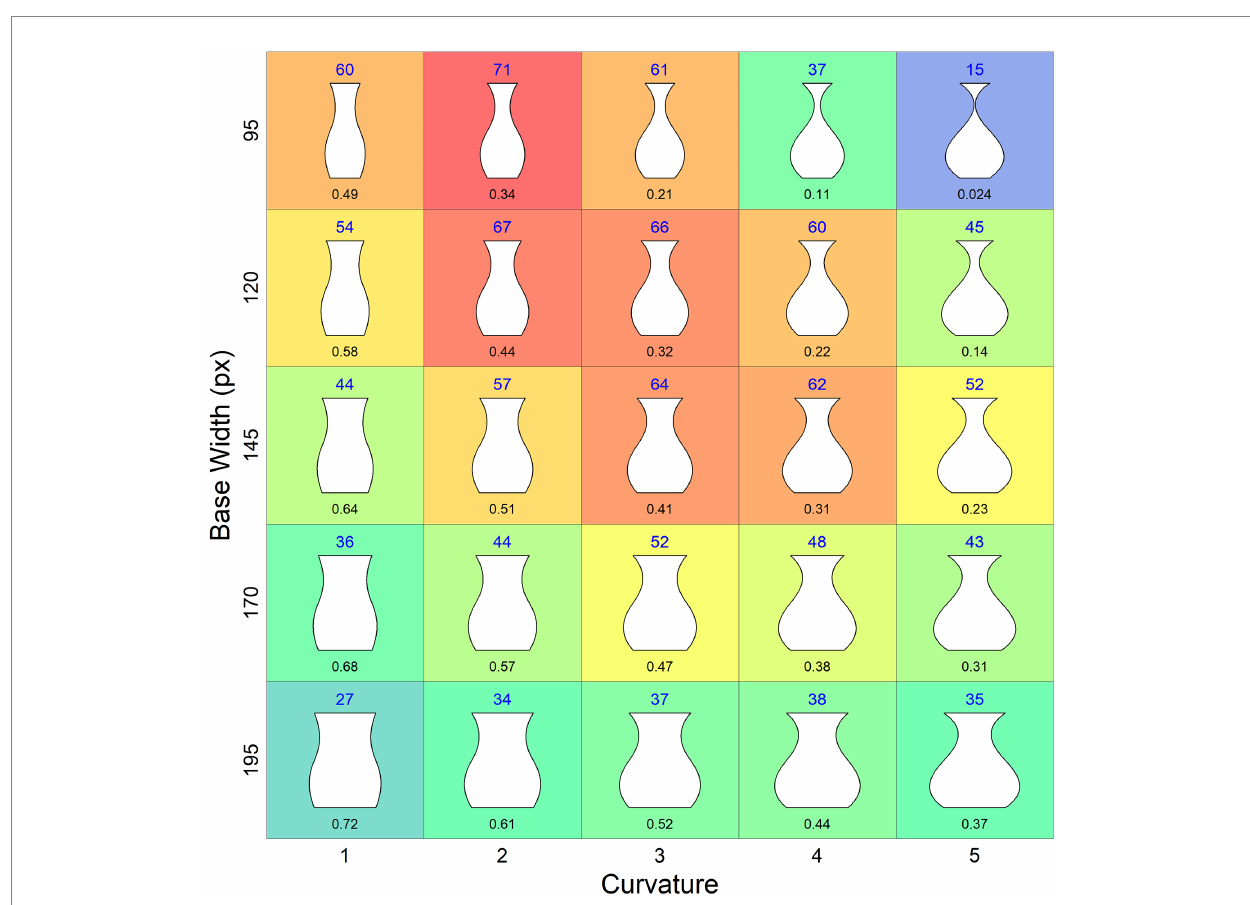
FIGURE 4 Mean beauty ratings of the vases. The values are provided as number above the vases as well as the color of a heat map (redundant coding). The numbers under the vases indicate the MMR.